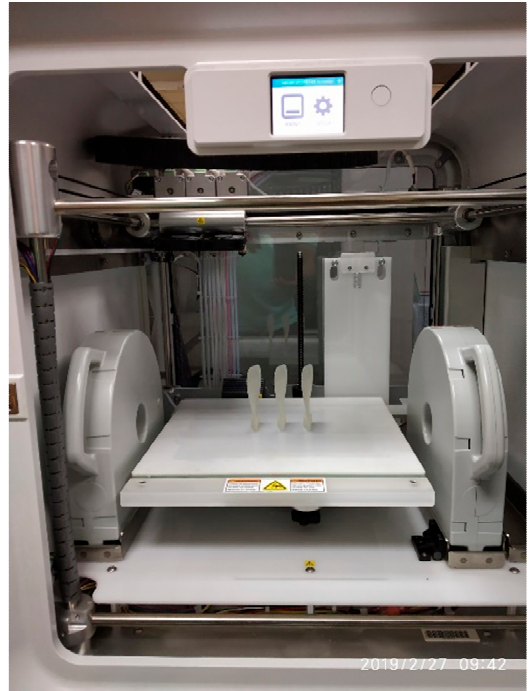
Figure 1. 3D printing machine with manufactured blades.